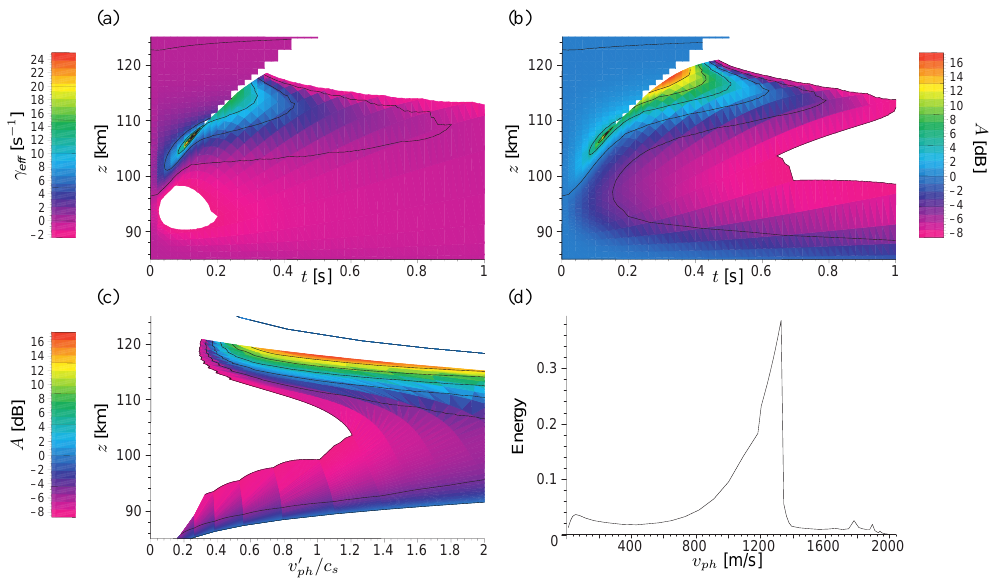
Fig. 8. Same case as in Fig. 7 but for a 100 mV/m field instead of a 50 mV/m field. Panel (a) and (b) same as in Fig. 7. Panels (c) and (d) : same as panels (a) and (e) of Fig. 6,